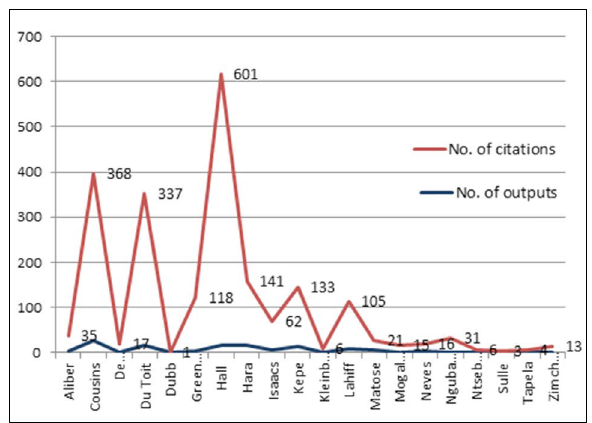
Figure 1: Publication and citation counts per author, according to Scopus. Onyancha and Ocholla 31 found in their research that Google Scholar provided a more comprehensive set of publication results than either Scopus or Web of Science. This finding is similar to our results, as shown in Table 5: 535 records, or 72% of the total outputs, were retrieved from Google Scholar – 54% more than that from Scopus. Table 5: Number of PLAAS outputs on Google Scholar, by document type